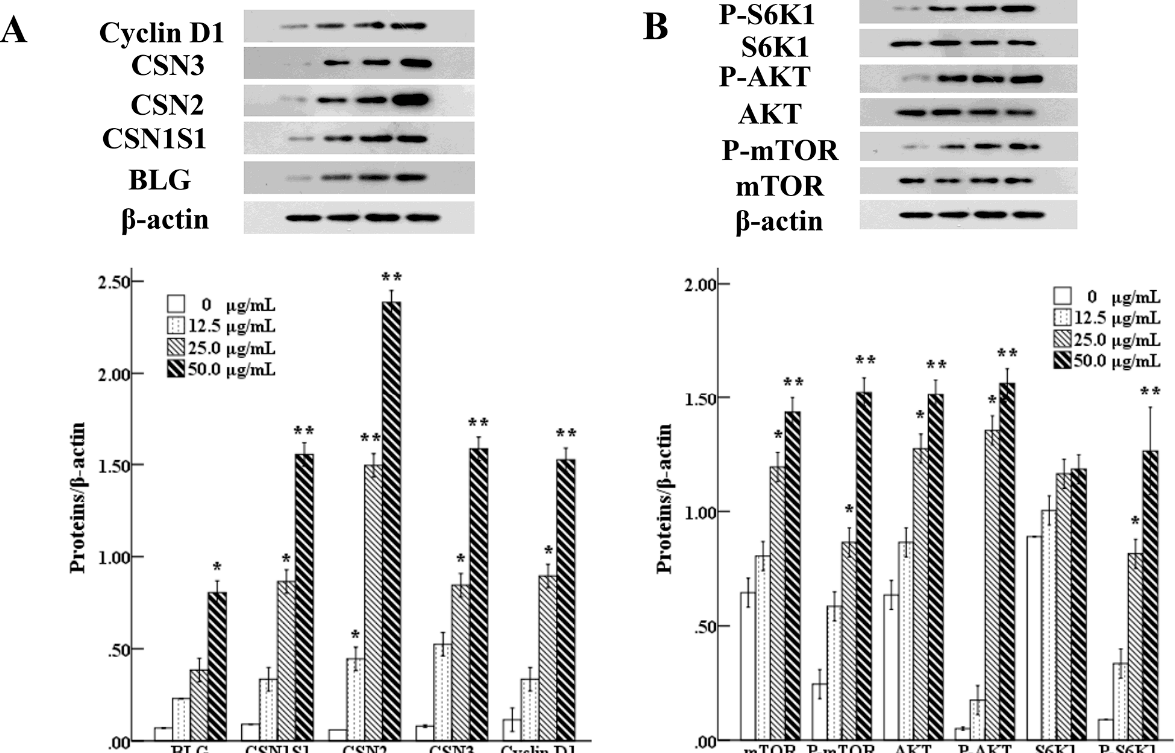
Figure 10. Effects of UEC4-1 on key genes of the lactation signaling pathway in MCF-10A cells. ( A ) Level of BLG, CSN1S1, CSN2, CSN3 and CyclinD1 protein were assessed by Western blotting analysis; ( B ) Changes in the level of lactation- and signaling-related protein were assessed by Western blotting analysis. β -Actin was assessed as a loading control. * significantly different from the control group at p < 0.05, ** significantly different from the control group at p < 0.01.